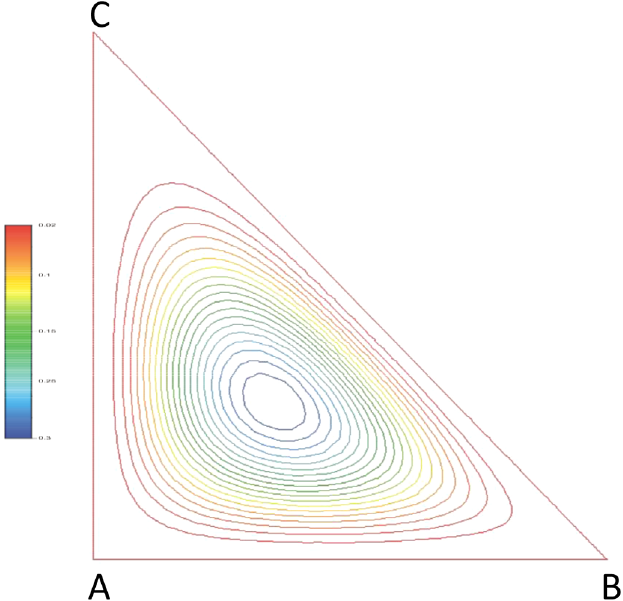
Fig. 9. Stream function contour of the triangular cavity with ¼ 0 , BC, u =0, boundary condition on the walls, AB, ∂ u ∂ n Pr = 0.71, Ra = 10 3 .